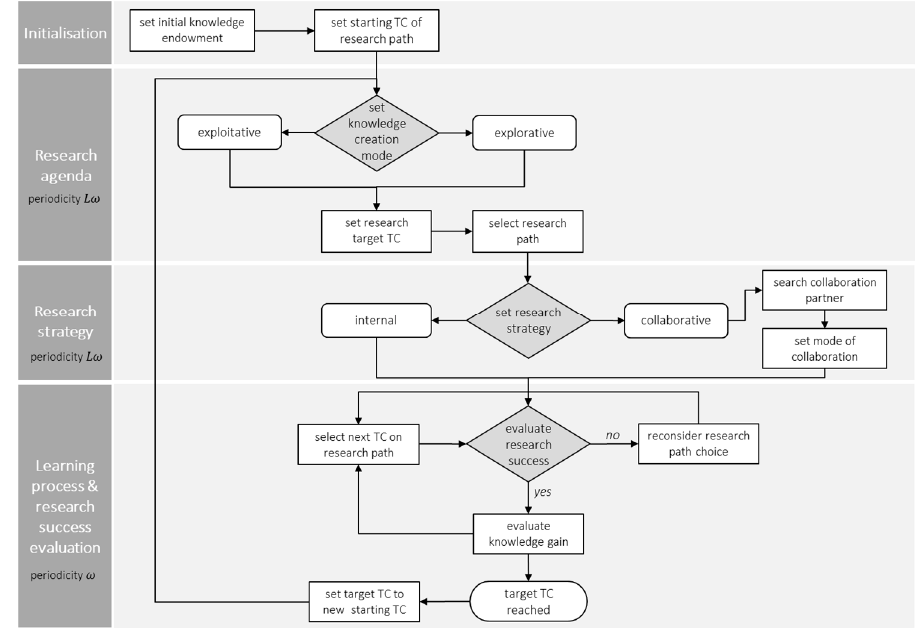
Figure A1. Detailed illustration of agent’s knowledge creation process.